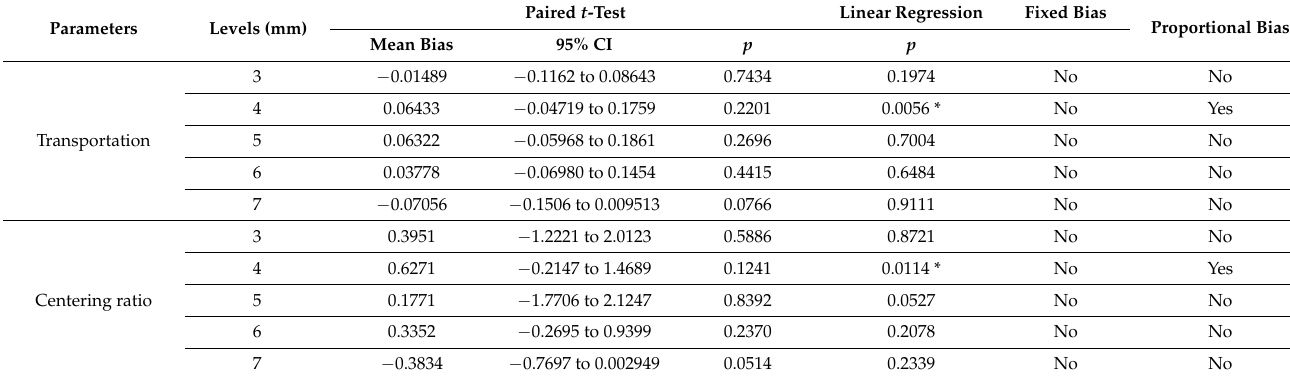
Table 1. Mean bias, confidence intervals, p values in two statistical tests, fixed or proportional bias at each level for the transportations and centering ratios of the two methods’ measurements in the mesio-distal direction.